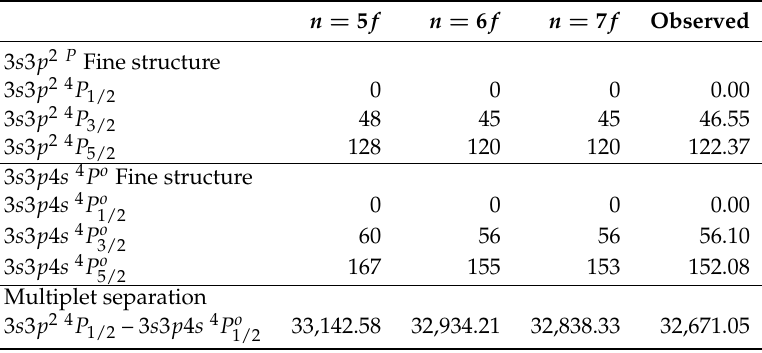
Table 2. Convergence of the energy level structure from a core-valence plus valence correlation calculation is compared with observed data [4,7]. All results are in cm − 1 . n = 5 f n = 6 f n = 7